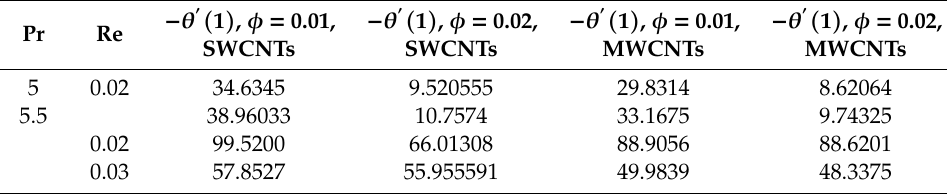
Table 5. The impact of Pr, Re, φ , versus the Nusselt number. When β = 1.1, M = 1.7.